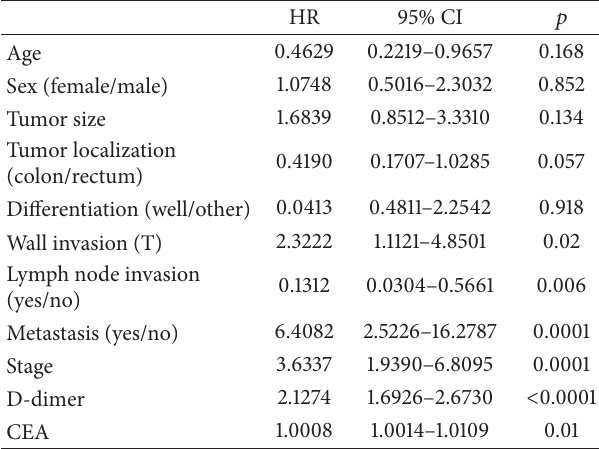
Table 2: Evaluation of the prognostic significance of the parameters using the univariate analysis of